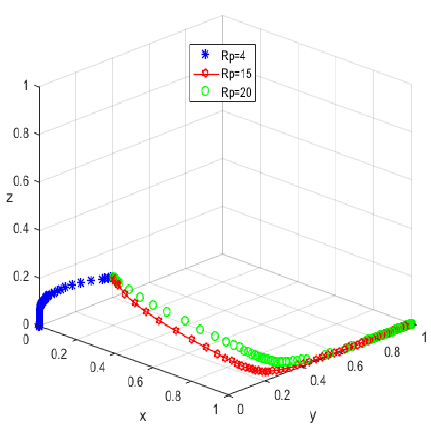
Figure 12. Trend graph for R P